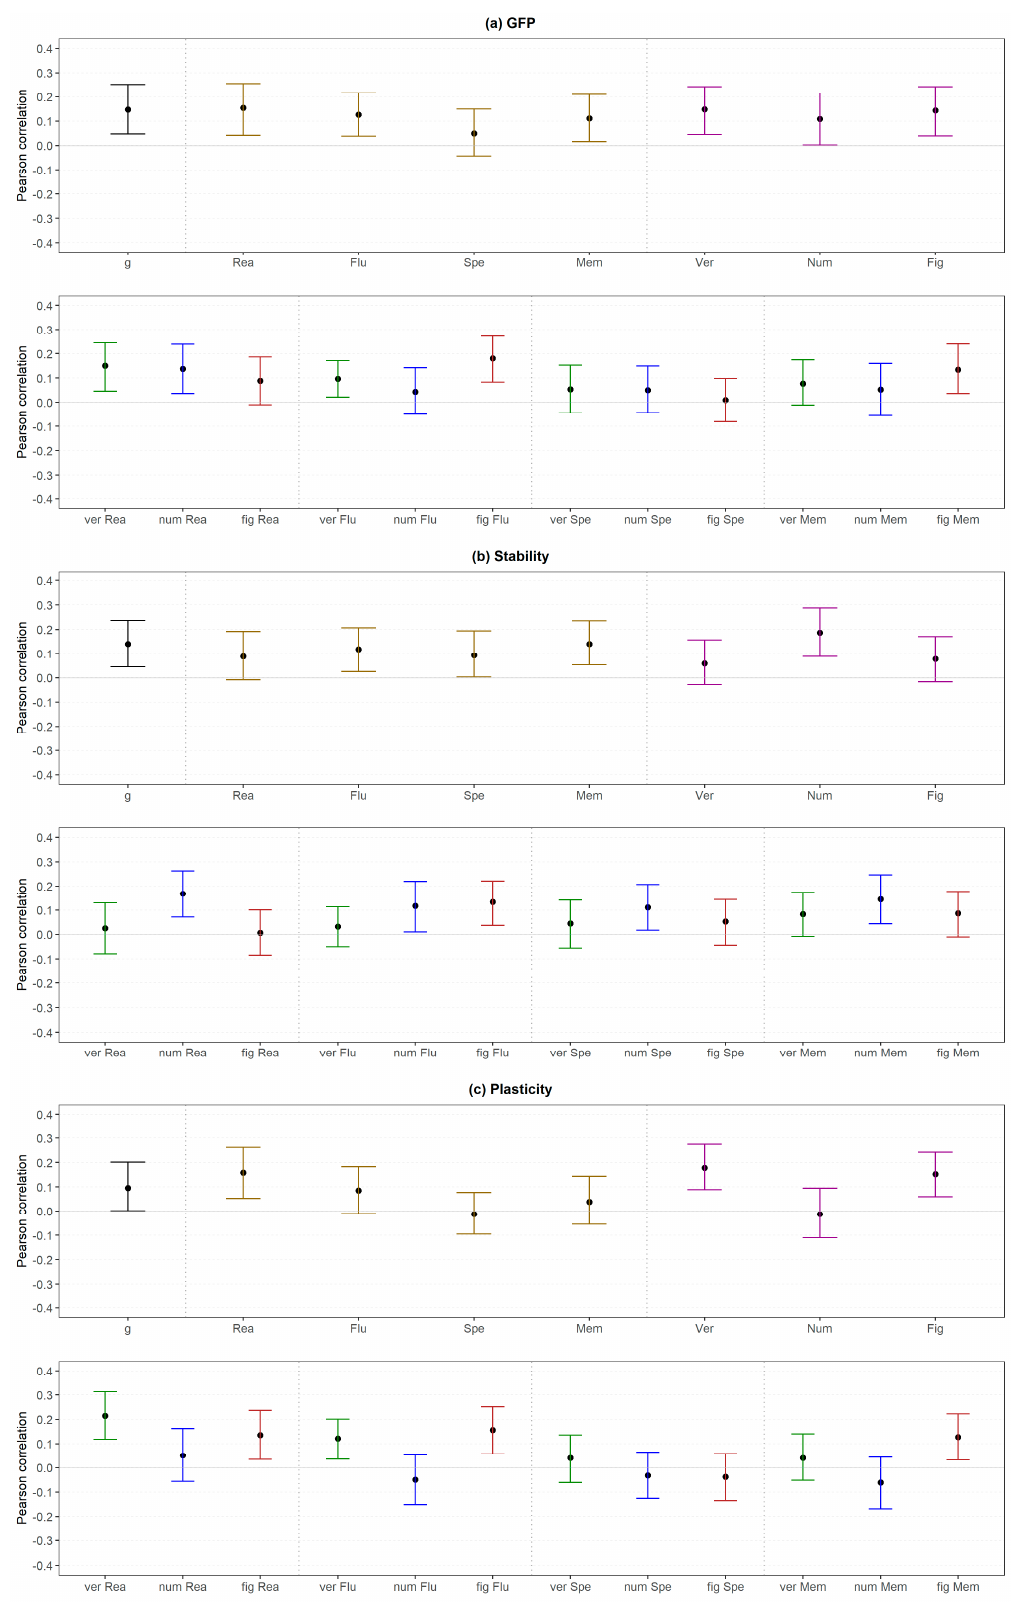
Figure 10. Study 2: Correlations between intelligence and higher-order factors of personality: ( a ) GFP, ( b ) Stability, ( c ) Plasticity. Rea = reasoning, Flu = fluency, Spe = perceptual speed, Mem = memory, Ver = verbal (intelligence), Num = numerical (intelligence), Fig = figural (intelligence).